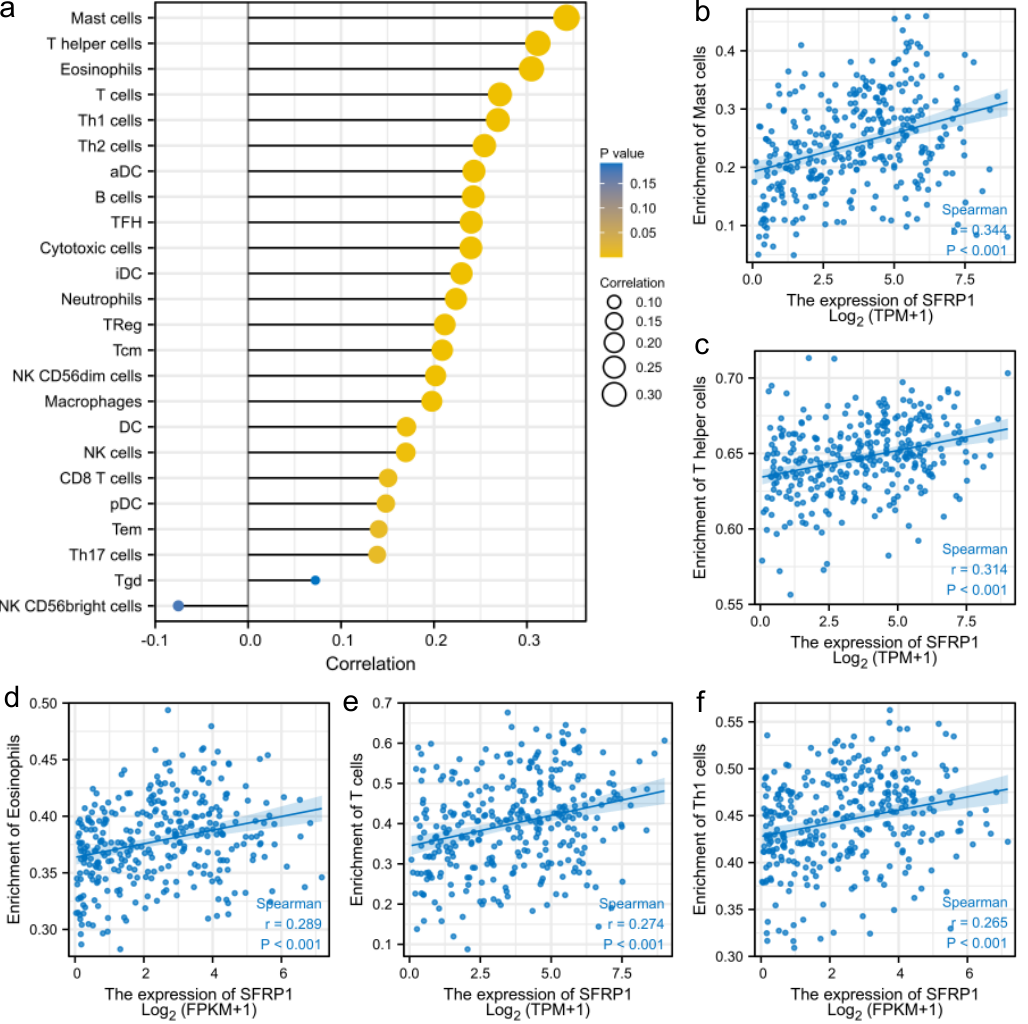
Figure 5 . Relationship between SFRP1 and tumor immune infiltration in OSCC; ( a ) correlations between SFRP1 and relative abundance of 24 immune cells in OSCC; scatter diagram of the SFRP1 expression and enrichment of ( b ) mast cells, ( c ) T-helper cells, ( d ) eosinophil cells, ( e ) T cells, and ( f ) Th1 cells.